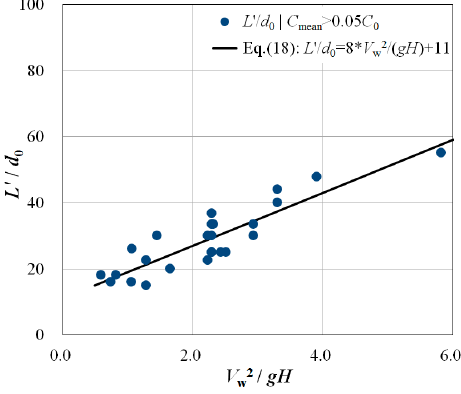
Figure 8. Distribution of swirling region length L ’.